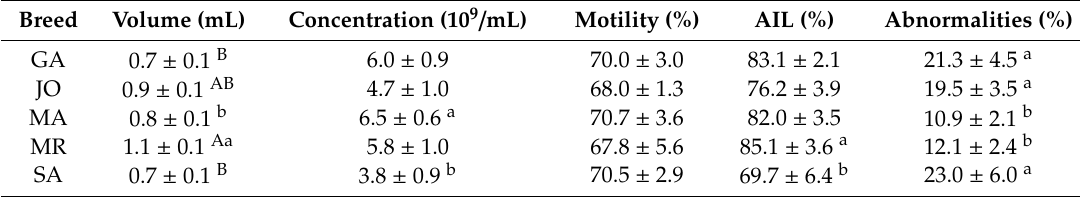
Table 2. Fresh semen qualitative characteristics in di ff erent breeds: Garganica (GA), Jonica (JO), Maltese (MA), Mediterranean Red (MR) and Saanen (SA). Data are expressed as mean ± SEM.